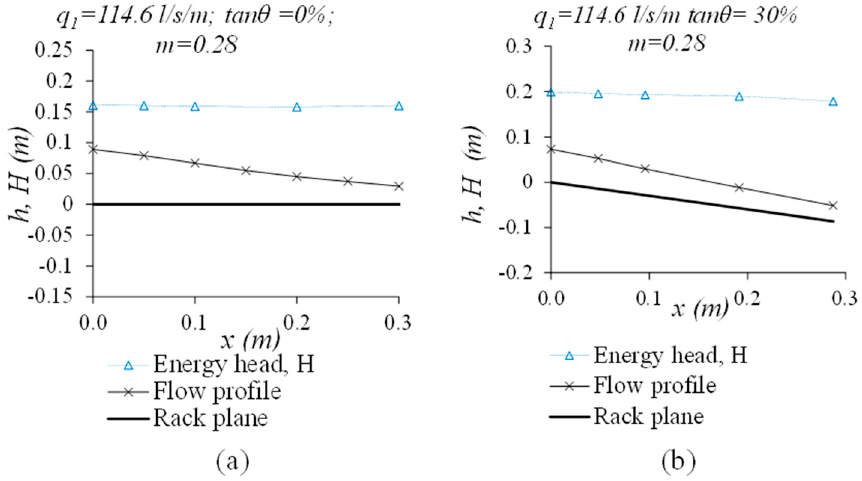
Figure 11. Energy head for approaching flow, q 1 = 114.60 L/s/m: ( a ) with horizontal slope; ( b ) with 30% slope.